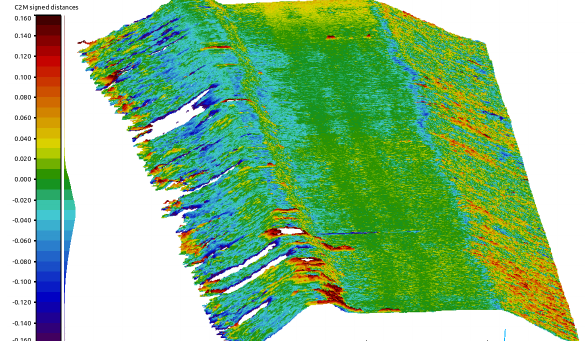
Figure 11: Perspective view over the comparison between the mesh triangulated from the 2014 model and the pointcloud from the 2015 campaign. The juxtaposition of 3D models illustrates that the highest changes happen on the slopes hit by the river or covered by nature. The central road seems stable, which is a good sign for the internal structure's